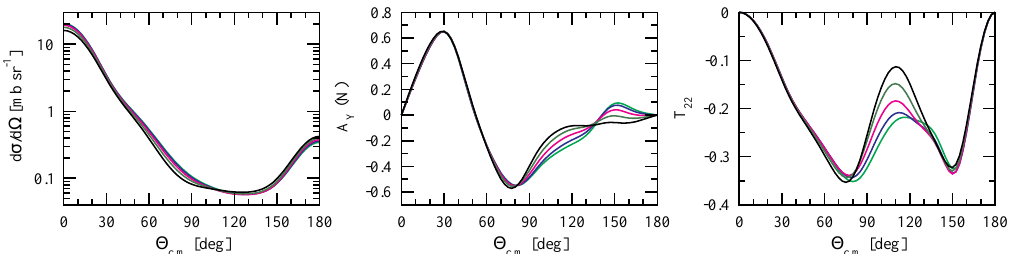
Figure 1: The differential cross section d σ/ d Ω (left panel), the nucleon analyzing ( N ) (middle panel) and the deuteron tensor analyzing power T power A y panel) for elastic nucleon-deuteron scattering at the laboratory nucleon energy E = 200 MeV as a function of the center of mass nucleon scattering angle θ with the chiral N4LO 2N potential [ 25, 26 ] employing the local coordinate-space regularization. The five lines show predictions obtained with five different regulator values R = 0.8, 0.9, 1.0, 1.1 and 1.2